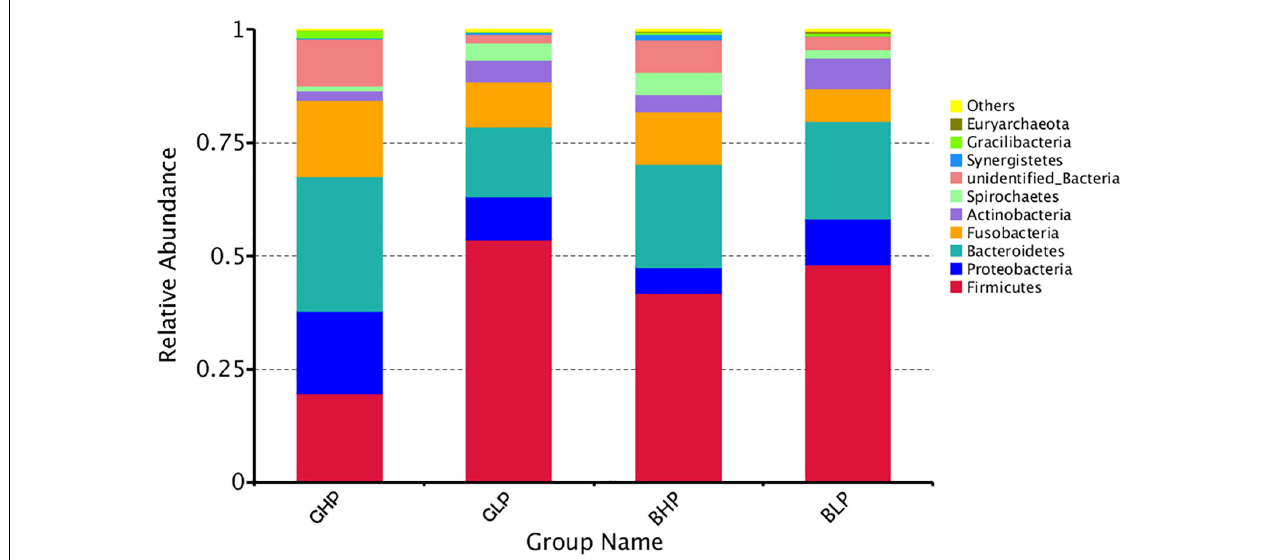
FIGURE 3 | Relative abundance of microbial community (Top 10) structure in the colonic content at Genus level. GHP, gilts fed high protein diet; BHP, barrows fed high protein diet; GLP, gilts fed low protein diet; BLP, barrows fed low protein diet. microbial different metabolites-related results mainly focused on the experimental gilts fed the HP and LP